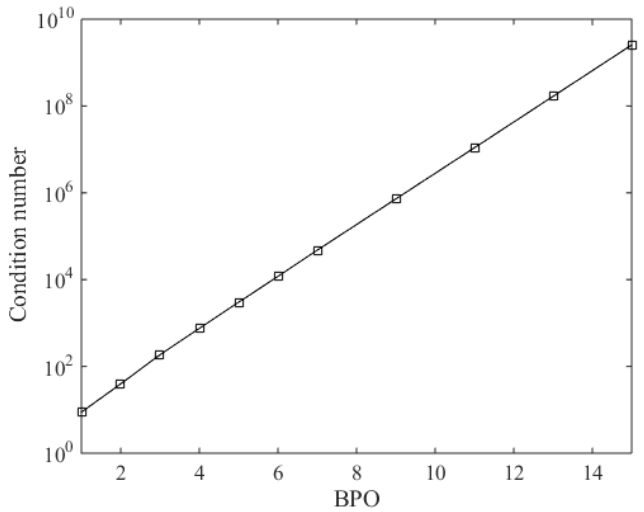
Figure 6. Spectral condition number of the parameterization matrix. BPO: Bernstein polynomials.